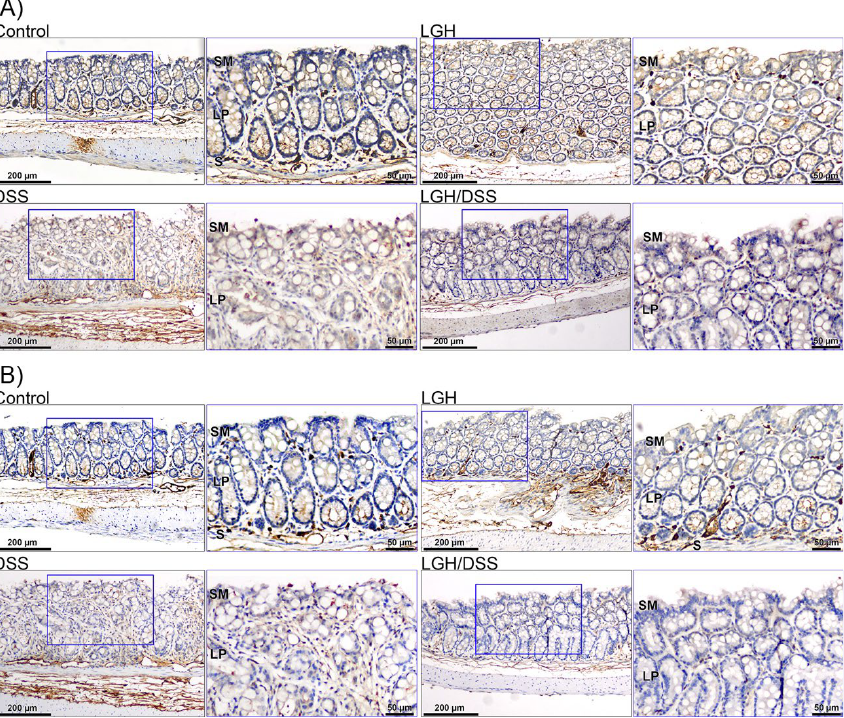
Figure 5. Representative immunohistochemical staining for the expression of CD3 and CD4 in the colons of different groups. Colon tissue sections from control group, LGH group, DSS group, and LGH/DSS group (scale bar, 200 μm) were stained with CD3 ( A ) and CD4 ( B ). Each inset represented the corresponding area (blue square) at higher magnification (scale bar, 50 μm). DSS, dextran sodium sulfate; LGH, longish glucomannan hydrolysates; SM, superficial mucosa; LP, lamina propria; S, submucosa.